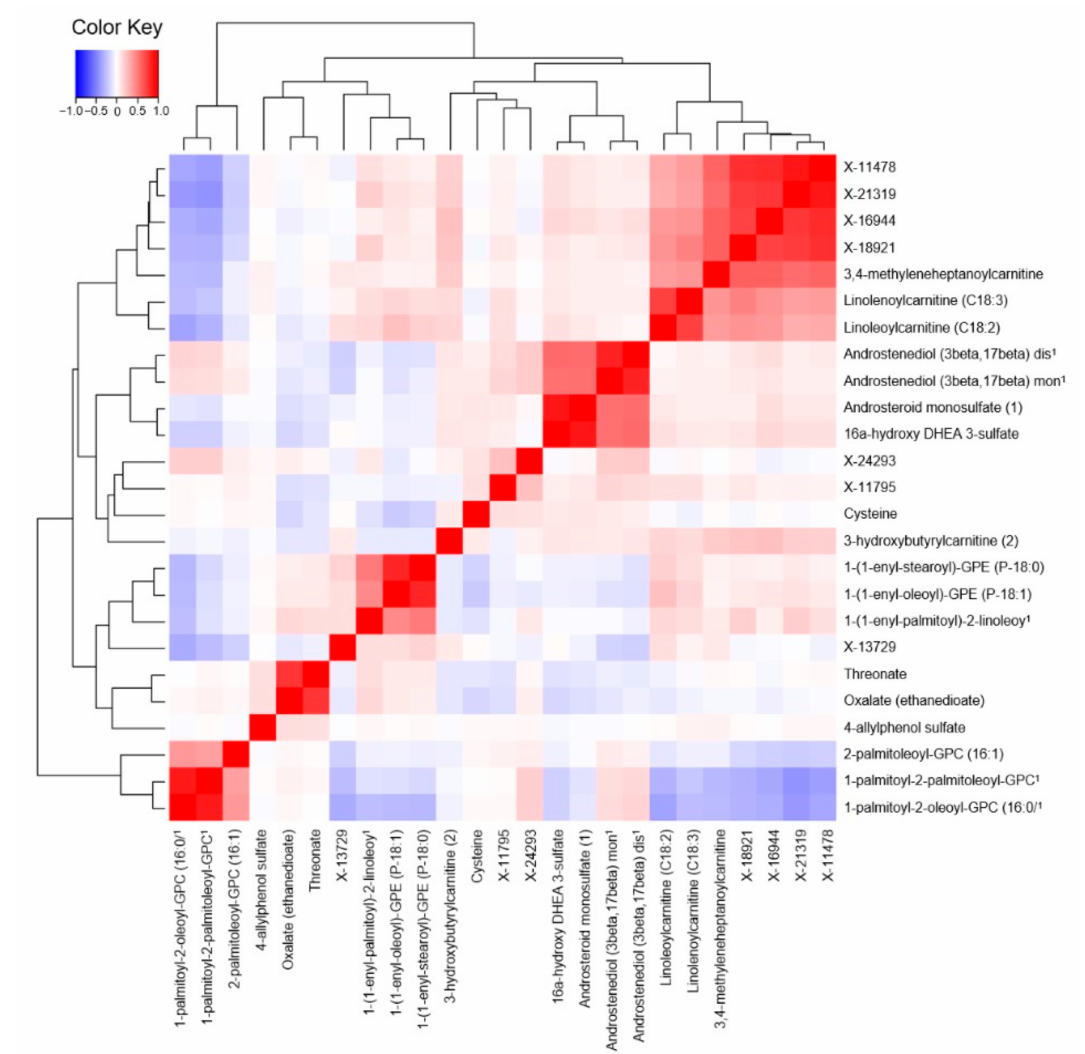
Figure 4. Heat map depicting pairwise correlations between the 24 metabolites associated with breast cancer risk. Metabo- lites were ordered using hierarchical clustering analysis as shown by light grey lines on the top and left sides. The key shows how colors correspond to the different Pearson correlation coefficients. For reference, the light red square for linoleoylcarnitine (C18:2) and 1-(1-enyl-oleoyl)-GPE (P-18:1) represents a correlation of 0.25, the medium red square for 16alpha-hydroxy DHEA 3-sulfate and androstenediol (3beta,17beta) monosulfate (2) represents a correlation of 0.55, and the dark red square for X-21319 and X-18921 represents a correlation of 0.75. The diagonal dark red line is the identify line, i.e., the correlation of 1 when comparing a metabolite against itself. 1 Abbreviations in order of appearance (left to